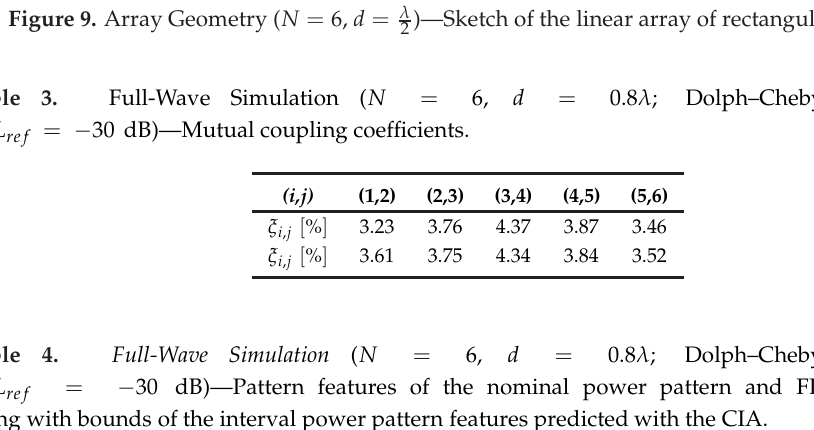
Figure 9. Array Geometry ( N = 6, d = λ